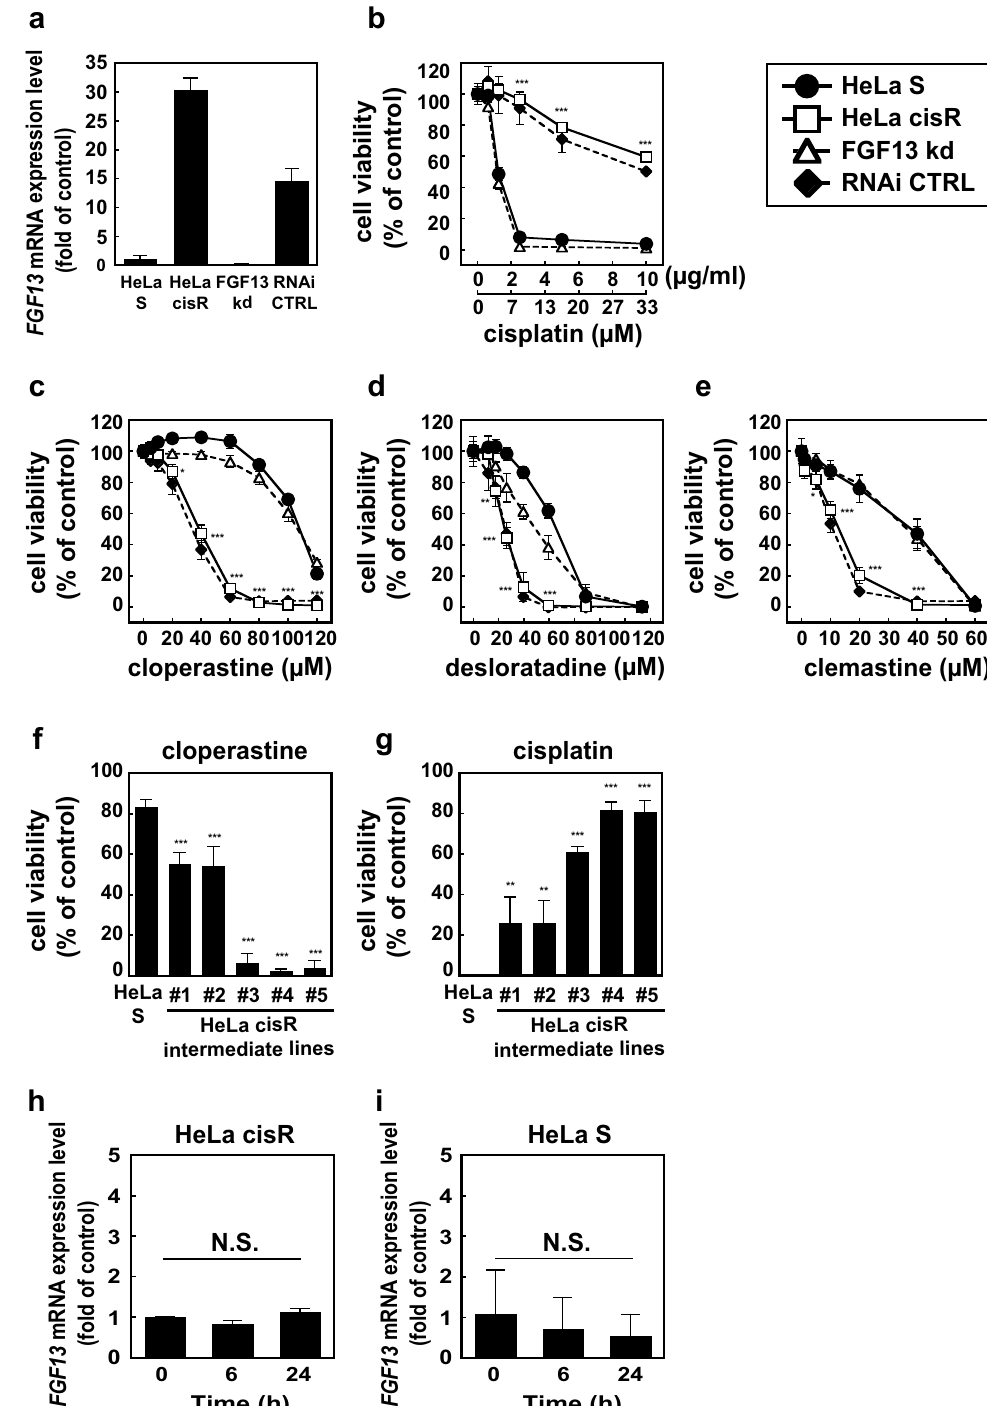
Figure 4. Cytotoxicity of H1 receptor antagonists is dependent on the levels of FGF13 expression and cisplatin resistance. ( a ) Relative expression level of FGF13 in each cell line. ( b – e ) Cytotoxicities of cisplatin ( b ) and H1 receptor antagonists cloperastine ( c ), desloratadine ( d ), and clemastine ( e ) toward HeLa S cells, HeLa cisR cells, HeLa cisR cells in which FGF13 expression was suppressed by targeted siRNA expression (FGF13kd), and HeLa cisR cells in which degenerate siRNA was expressed (RNAi CTRL). Open squares, HeLa cisR cells; filled circles, HeLa S cells; open triangles, FGF13kd cells; filled diamonds, RNAi CTRL cells. ( f ) Cytotoxicity of 100 µM cloperastine toward HeLa S cells and five intermediate HeLa cisR cell lines, which were collected during the process of establishing the HeLa cisR cells (#1 to #5, adapted to 0.42, 0.84, 2.0, 6.0 and 8.0 µg/ml cisplatin in this order) and which differ in their expression of FGF13 mRNA. ( g ) Cytotoxicity of 10 µg/ml (33 µM) cisplatin toward HeLa S cells and the five intermediate HeLa cisR cell lines. ( h , i ) Separate cultures of HeLa cisR cells ( h ) and HeLa S cells ( i ) were treated with cloperastine for the indicated periods, after which relative expression of FGF13 mRNA was quantitated using RT-qPCRs. The results are presented as mean ± S.D. of sextuplicate ( b – e ) or triplicate ( a , f – i ) samples. Three separate experiments yielded essentially the same results. In panels ( b – g ) the significance of the difference between the results from HeLa S and HeLa cisR cells was determined with ANOVA (***p < 0.001; **p < 0.01; *p <